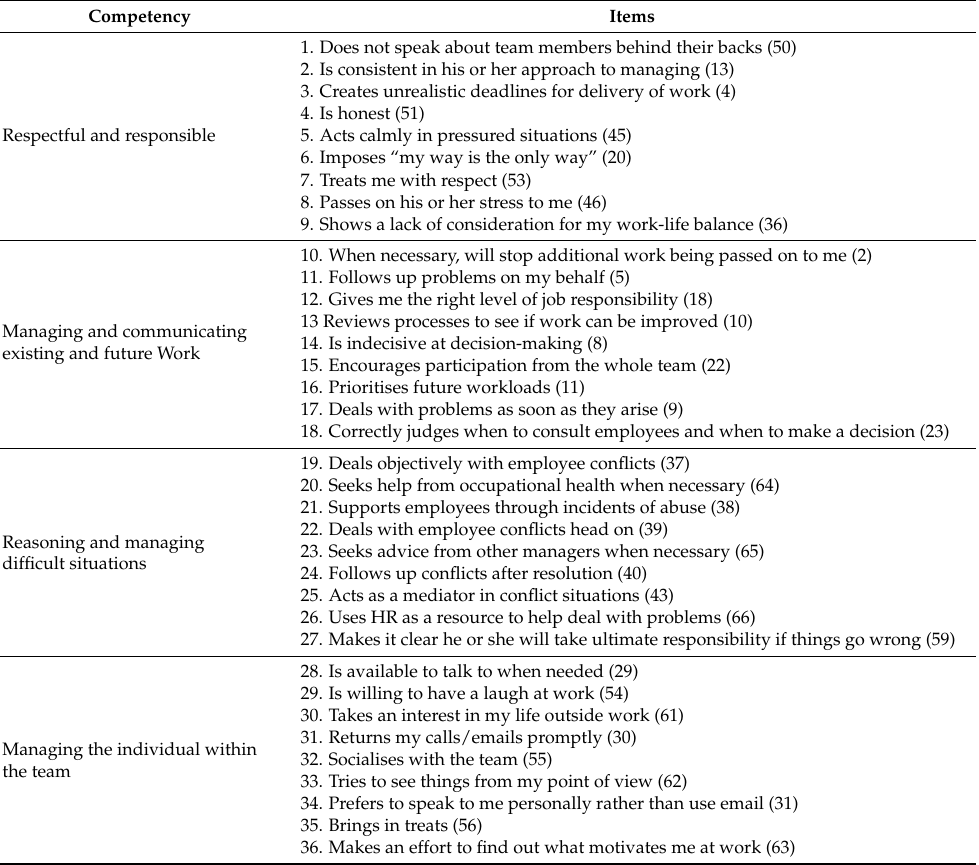
Table 1. The 36-item SMCIT (In parentheses the original item number in the 66-item version, Yarker et al.